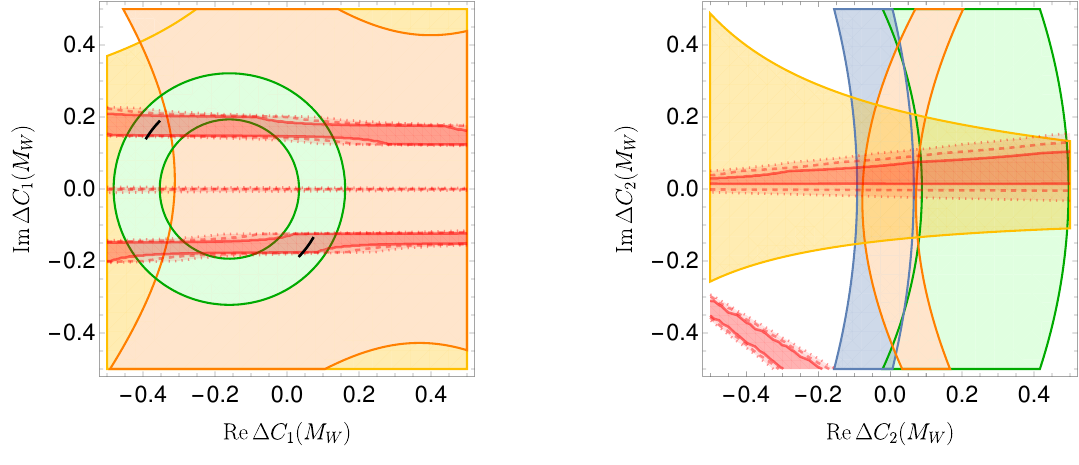
Figure 5. Left: constraints from B d J= K S and other constraints on the complex (cid:1) C 1 plane. ! The red horizontal bands uses a theory prediction only for O 1 , expected to be close to its naive- h i factorization value as reviewed in section 3.5. Each band shows regions of agreement at the 1 (cid:27) (solid), 2 (cid:27) (dashed), and 3 (cid:27) (dotted) levels. (Note that the band lying on the real axis only has 2 and 3 (cid:27) agreement, due to the small tension between (4.21) and (4.23)). On the black arcs, NF for both O c and r 21 is in agreement with data. Right: same, but for NP in (cid:1) C 2 . 1 i h